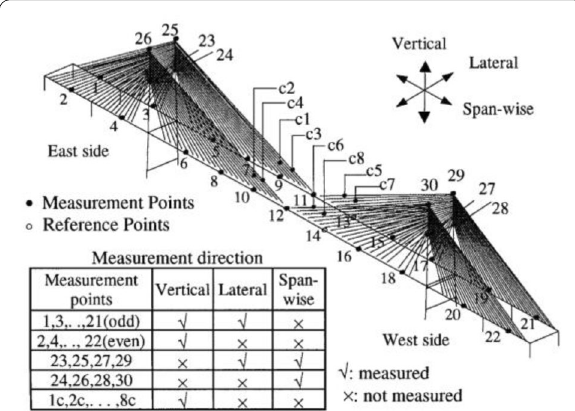
Fig. 5 Measurement locations of the long-span cable-stayed bridge with the 3D schematic view (Chang et al.,